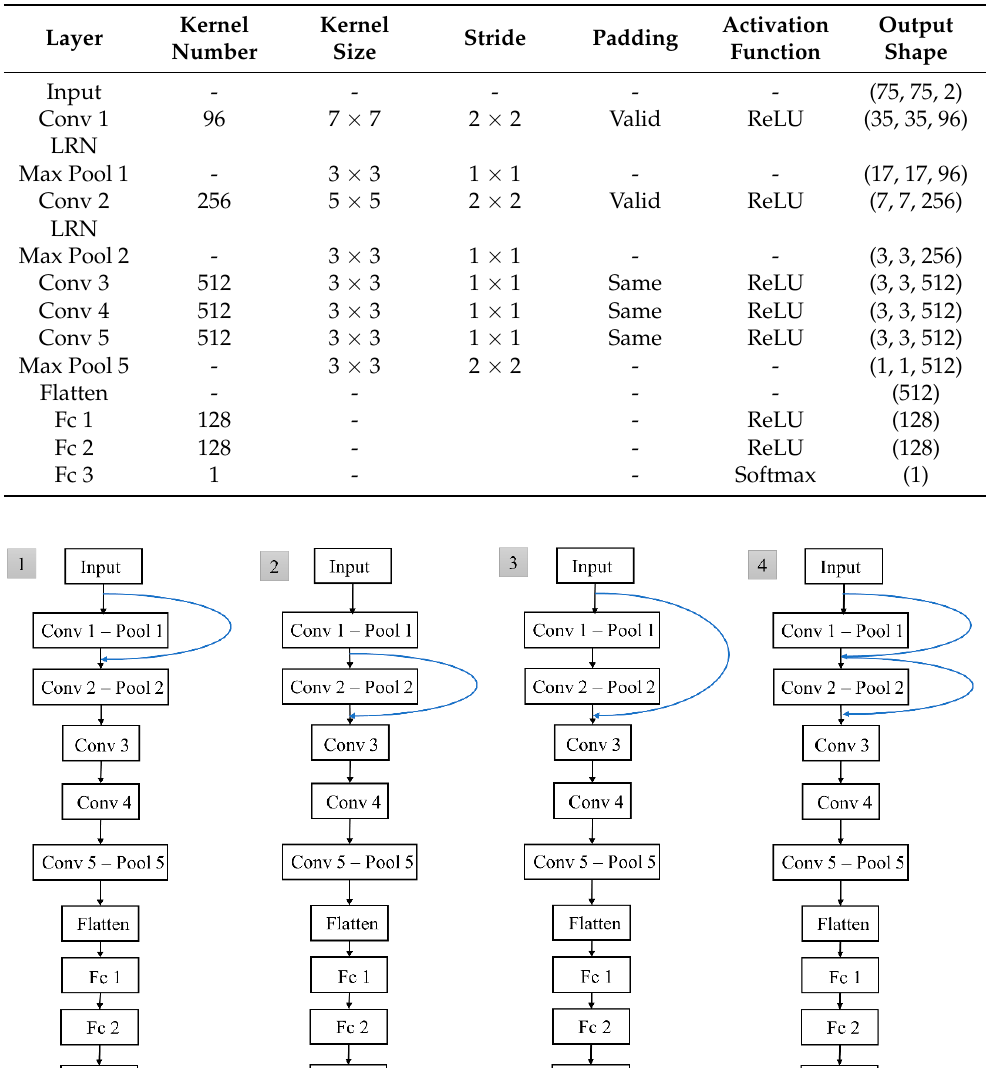
Table 1. Modified VGG-M configuration.